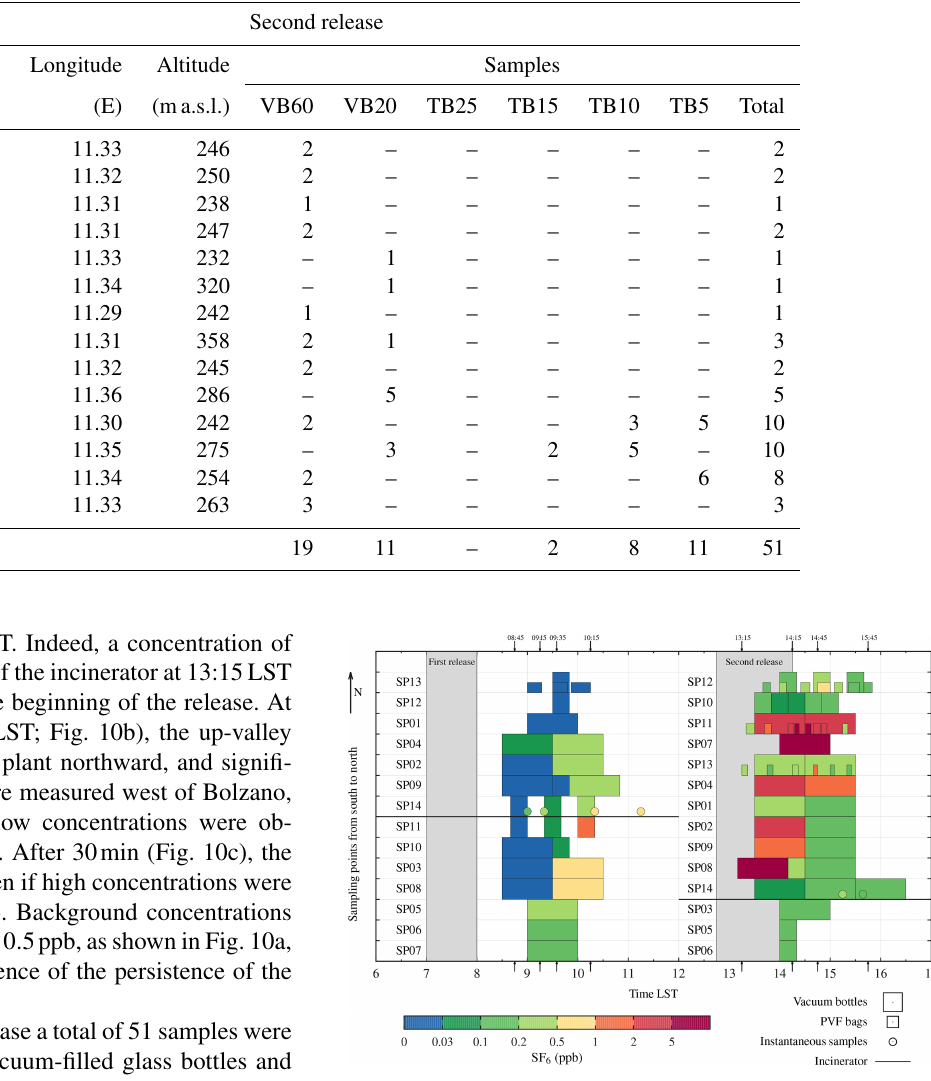
Figure 8. Tracer concentrations measured on 14 February 2017 af- ter each release. Air samples were collected by means of vacuum- filled glass bottles (large rectangles) and PVF bags (small rectan- gles). In addition, instantaneous samples of air (circles) were ana- lyzed. The sampling points are listed from north to south, while the two horizontal black lines indicate the latitude of the incinerator. The arrows at the top and bottom of the graph indicate reference time stamps (LST) for Figs. 9 and